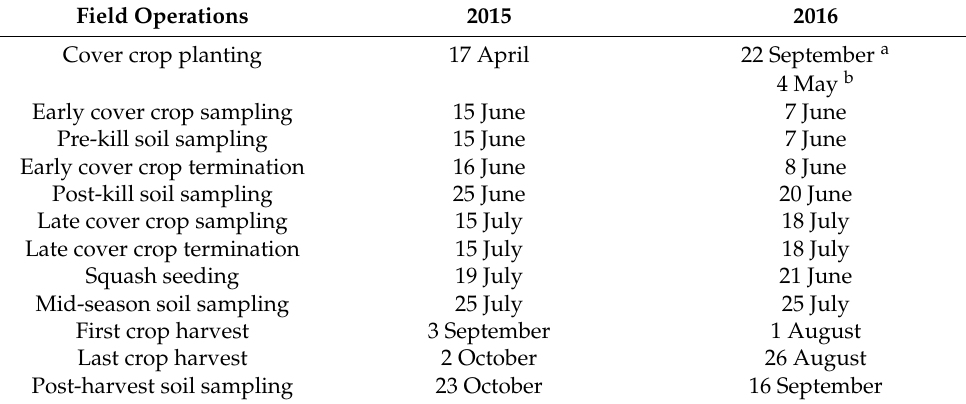
Table 1. Schedule of field